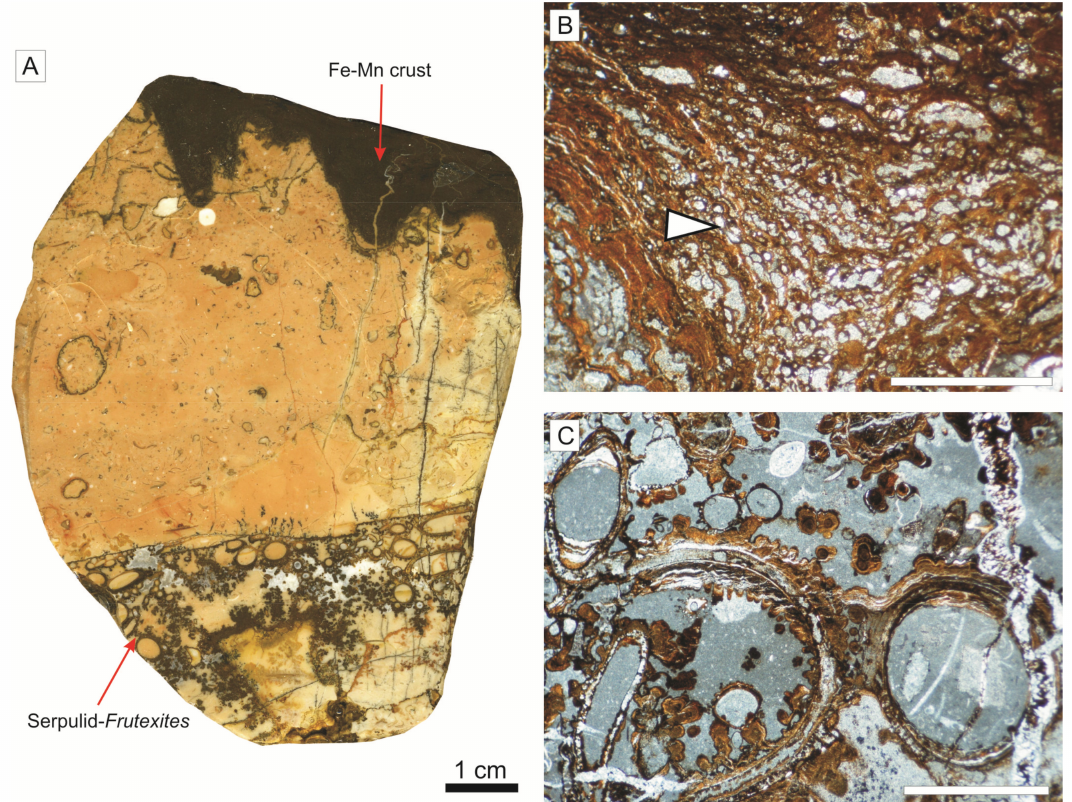
Figure 5. Ferruginous crusts from the Central External Subbetic developed on the complex unconformity of the Middle Jurassic. ( A ) Polished slab of neptunian-dike with serpulids and Frutexites colonizing the top wall of the cavity. In the upper part of the sample is preserved a paleo-relief fossilized by an iron crust. ( B ) Planar laminated iron crust with encrusting foraminifera (arrow). Scale bar = 1 mm. ( C ) Detail of the serpulids colonized by dendritic iron crusts assigned to Frutexites . Scale bar = 1